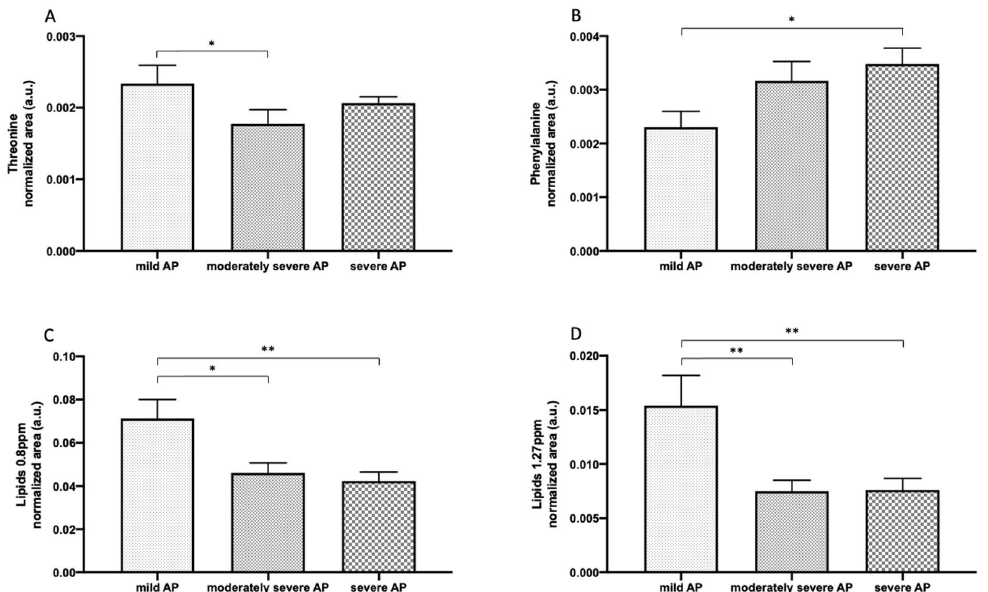
Figure 8. The quantitative abundance of different metabolites in the plasma of different degrees of biliary AP severity. Results are expressed as mean ± SEM. The differences versus control are marked by *, where * represents p < 0.05 and ** p < 0.01. Comparison of Fisher’s least significant difference post hoc test: ( A – C ); Comparison of the Tukey’s post hoc test: ( D ).